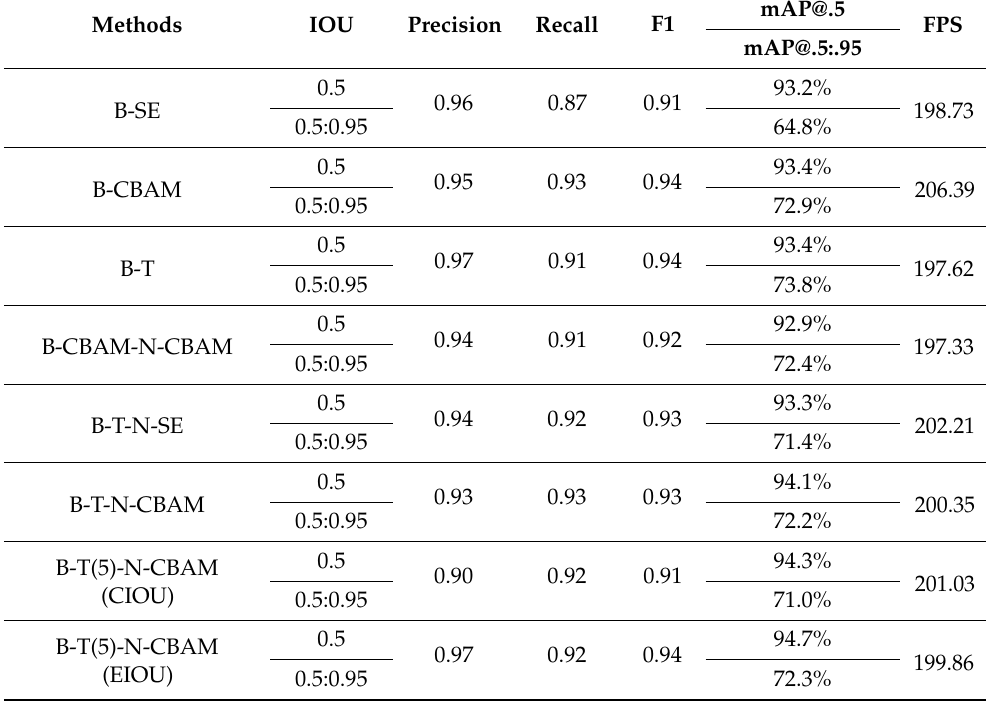
Table 7. Trick ablation